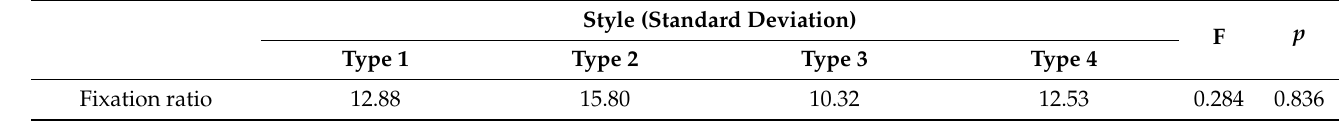
Table 14. Homogeneity of variance test for the proportion of key fixation points in different